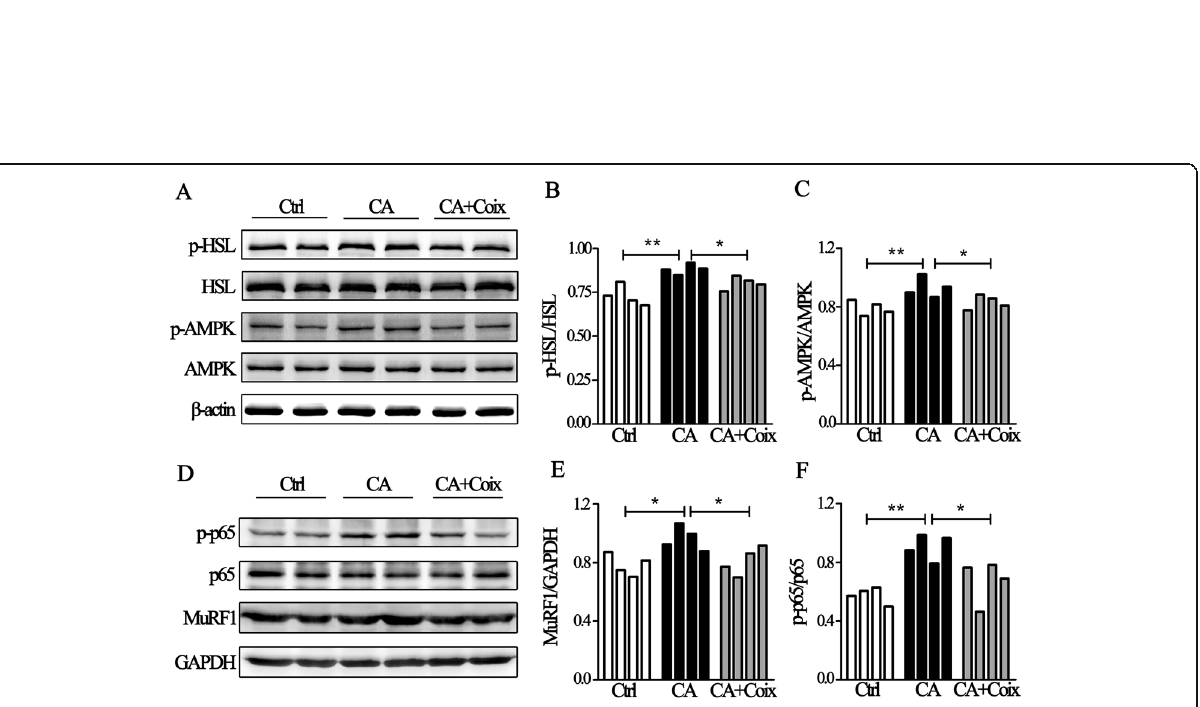
Fig. 4 The NF- κ B and AMPK pathway were involved in anti-cachectic effects of CSO. a . Representative Western-blot images exhibit the expression of p-HSL (Ser660), HSL, p-AMPK (Thr172), AMPK inthe Ctrl group, CA group, and CA + Coix group. b .The band densityanalysis showed that p-HSL/ HSL in adipose tissue differed significantly between three groups (4 samples per group). c .The quantification of band density showed that p- AMPK/AMPK differed significantly between three groups (4 samples per group). d .Representative Western-blot images exhibit the expression of phospho-p65 (Ser536), p65 and MuRF1 inthe Ctrl group, CA group, and CA + Coix group. e .The quantification of band density revealed the increased ratio of MuRF1 to GAPDH in muscle tissue induced by cachexia was decreased by CSO administration (4 samples per group). f . The band densityanalysis exhibited that phospho-p65/p65 was elevated in CA group compared to Ctrl group while CSO administration significantly decreased the ratio (4 samples per group). Values were expressed as mean ± SEM (* P <0.05, ** P